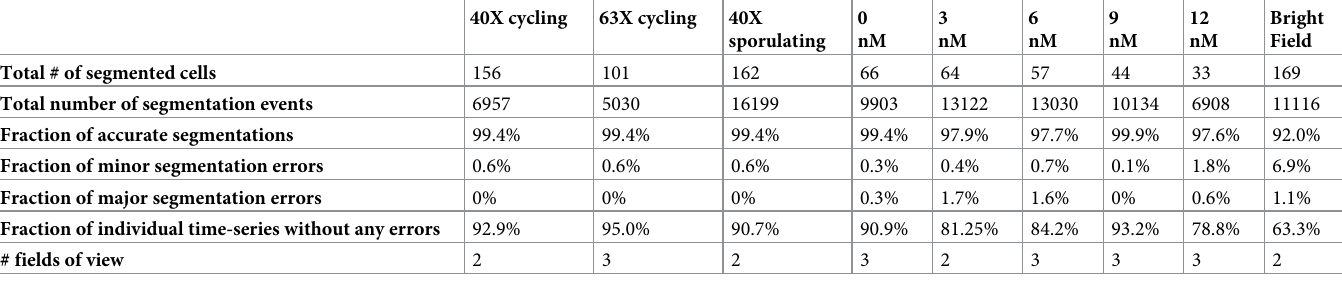
Table 7. Overall performance of all example